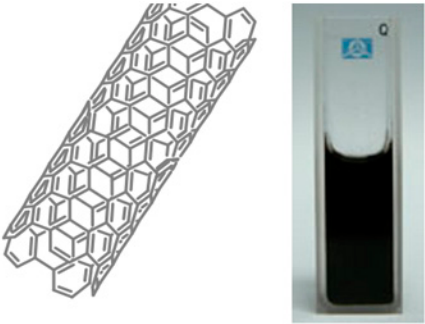
Figure 9. A single-walled carbon nanotube and an aqueous solution of SWNTs functionalized by PEG-SWNTs with highly optical properties, which are considered excellent platforms for biomedical imaging [99]. Reproduced with copyright permission from Springer Nature, 2010.